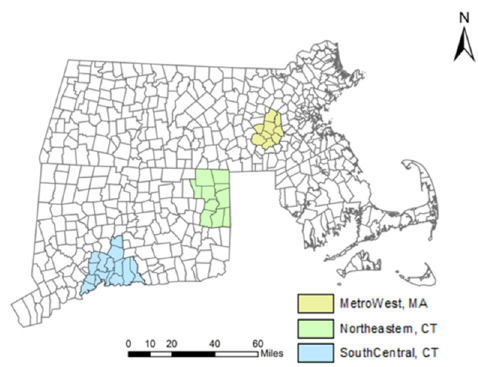
Figure 2. The three planning regions in Massachusetts (MA) and Connecticut (CT).